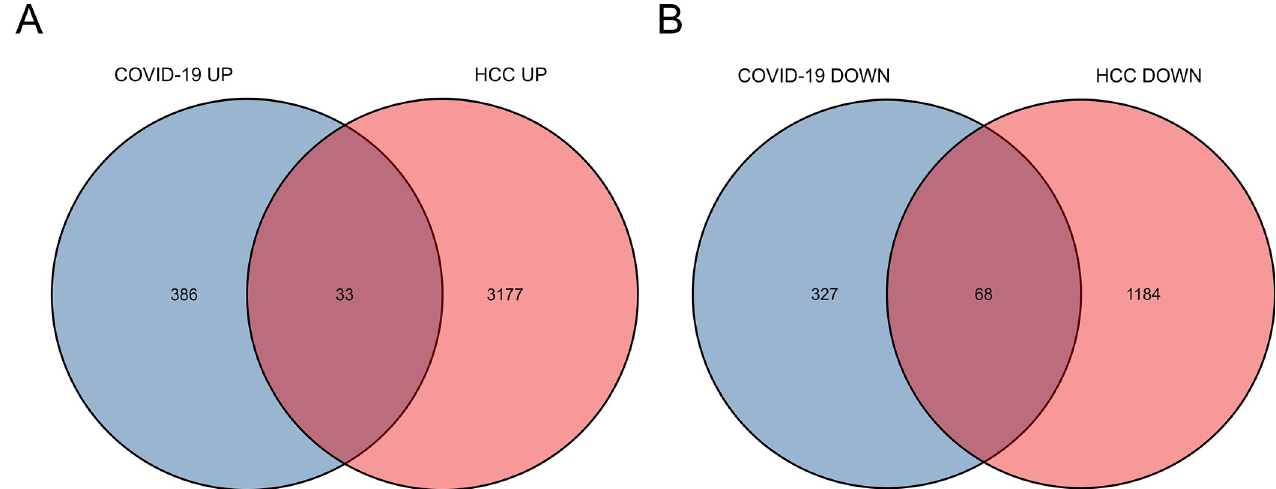
Fig 2. Common differentially expressed genes represented by Venn diagrams. 33 commonly differentially up-regulated expressed genes and 68 commonly differentially down-regulated expressed genes were identified from 814 differentially expressed genes in SARS-CoV-2 infection and 4462 differentially expressed genes in HCC